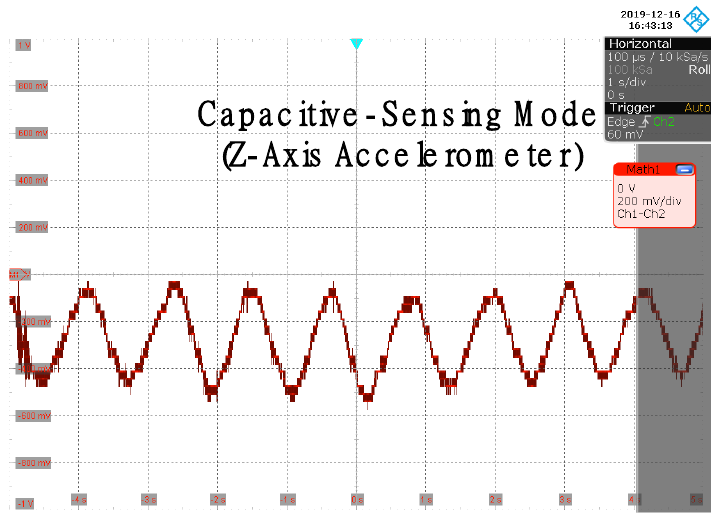
Figure 18. The real-time measurement result using a capacitive z-axis accelerometer. Table 3. Performance summary and comparison.